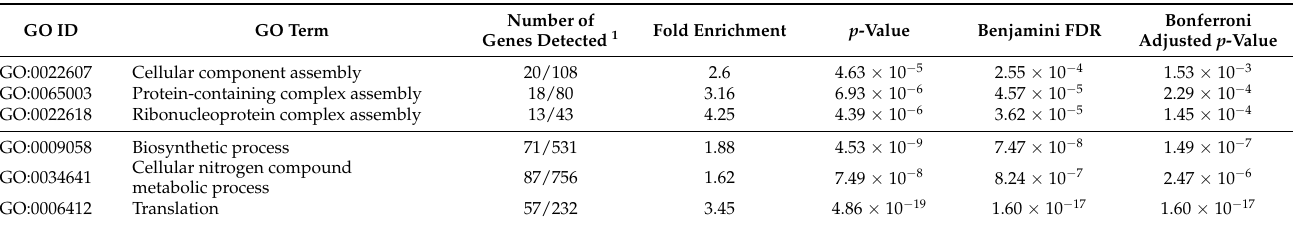
Table 1. Analysis of biological processes enrichment in the PbPP1c interactome in schizonts limited to GO SLIM